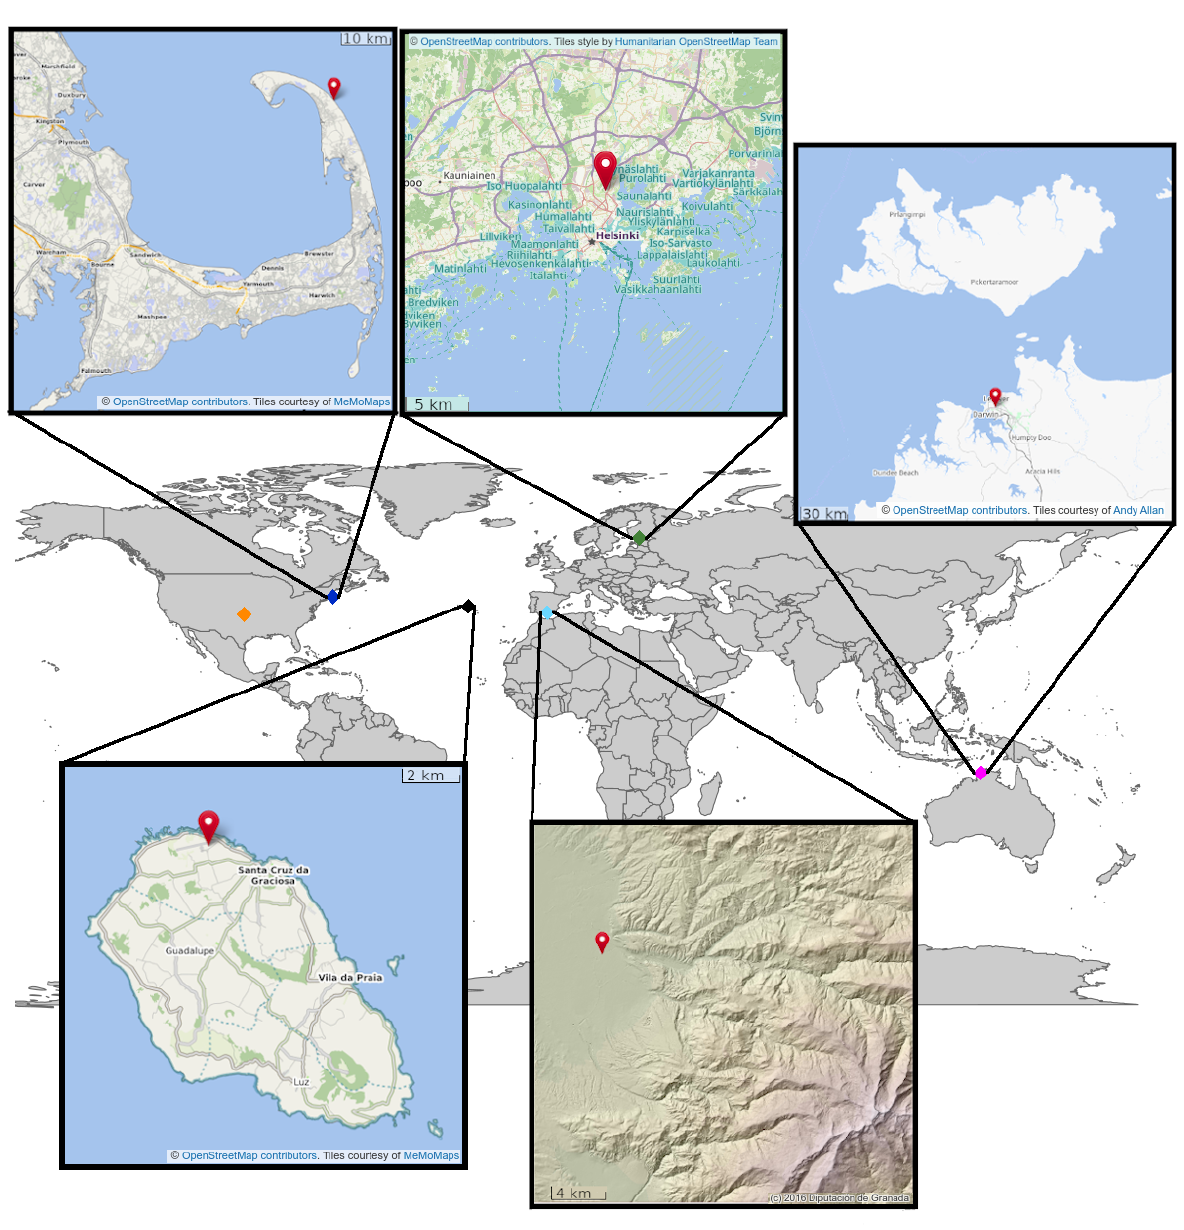
Figure 1. Map displaying the locations of the Doppler lidar observation stations (SGP orange, Cape Cod blue, Graciosa black, Granada cyan, Kumpula green, and Darwin magenta), with inset zoomed-in maps highlighting the most important terrain features (no zoomed-in map is provided for SGP, which is located in flat plains). For Granada, a topographical map has been selected to highlight the proximity of the mountains and the various valleys leading into the city. The Doppler lidar is located near the western edge of the city, with the eastern edge extending approximately 2km eastwards to where the mountain valleys begin. The topographical map has been adapted from Granada’s Geographical Information Systems website, while other inset maps were obtained from Open Street Map (© OpenStreetMap contributors 2022. Distributed under the Open Data Commons Open Database License (ODbL)